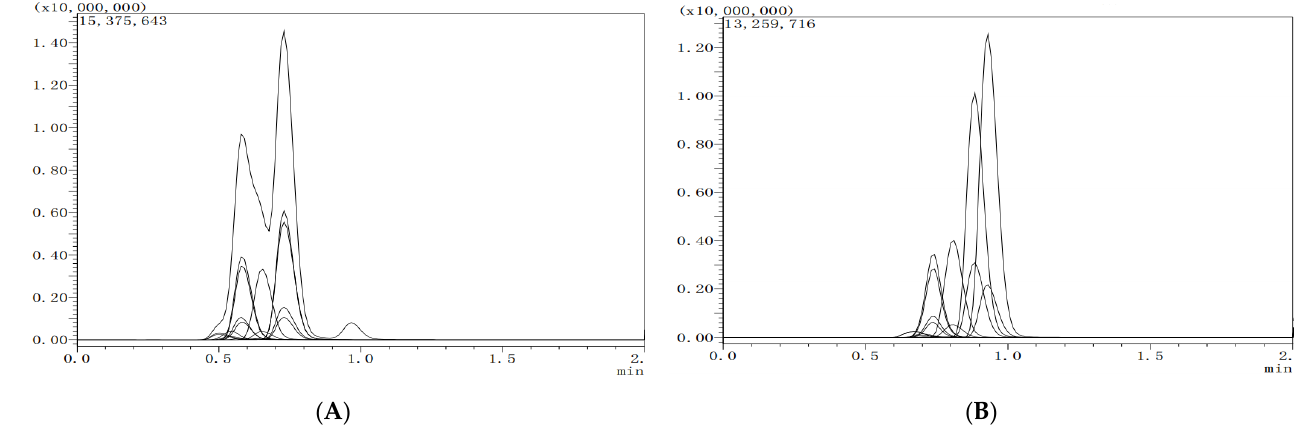
Figure 1. The total ion chromatogram of eight targeted compounds separated by the two different columns (lateral axis is time, and longitudinal axis is response intensity). ( A ) Shim-pack GIST-HP C18, 50 mm × 2.1 mm, 3.0 μ m; ( B ) InfinityLab Poroshell C18, 75 mm × 2.1 mm, 2.7 μ m. C18, 50 mm × 2.1 mm, 3.0 µ m; ( B ) InfinityLab Poroshell C18, 75 mm × 2.1 mm, 2.7 µ